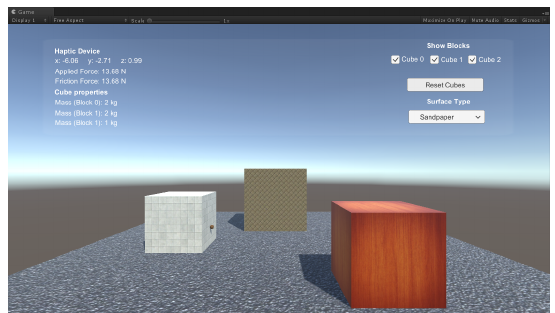
Figure 18. Unity Forces simulator: User is moving the second virtual block to the left.